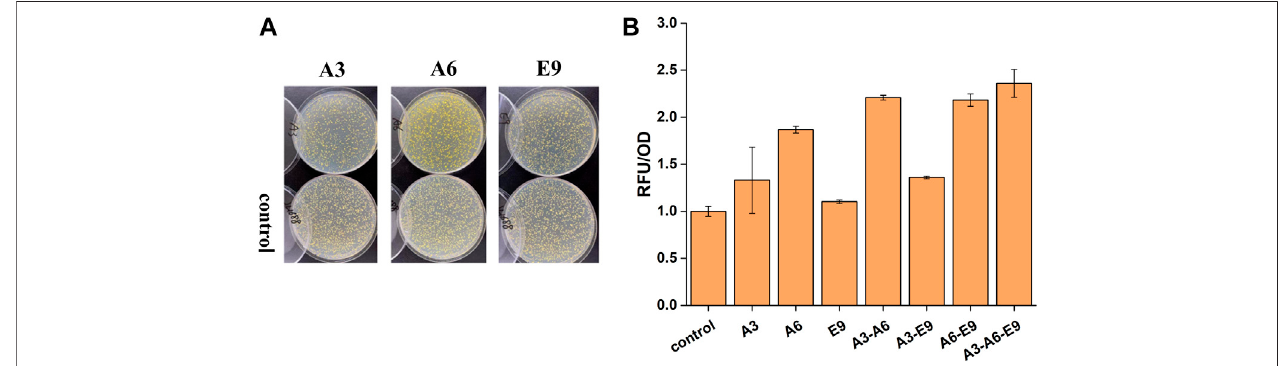
FIGURE 2 | The effects of AtGRP7 (A3), AtMSBP1 (A6), and AtCOL4 (E9) on the functional expression of CYP76AD1 and accordingly the production of betaxanthin. (A) The change of clone color on agar plates after transformation of the target genes. (B) The change of fl uorescence intensity after transformation of the target genes, as well as synergistic/additive interactions between AtGRP7 (A3), AtMSBP1 (A6), and AtCOL4 (E9). Error bars represented the mean ± s.d. of biological triplicates. RFU/OD refers to the fl uorescence intensity normalized to cell